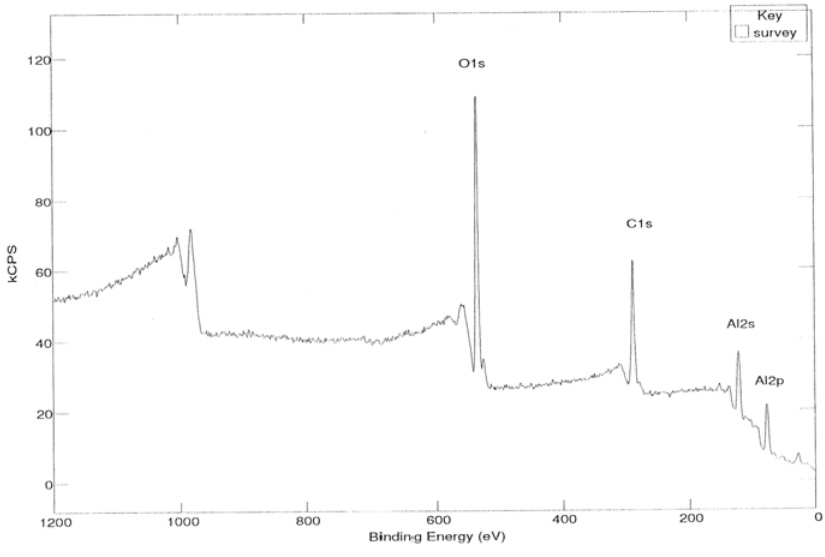
Figure 1. XPS full scan spectra of Al power (94%) by argon ion